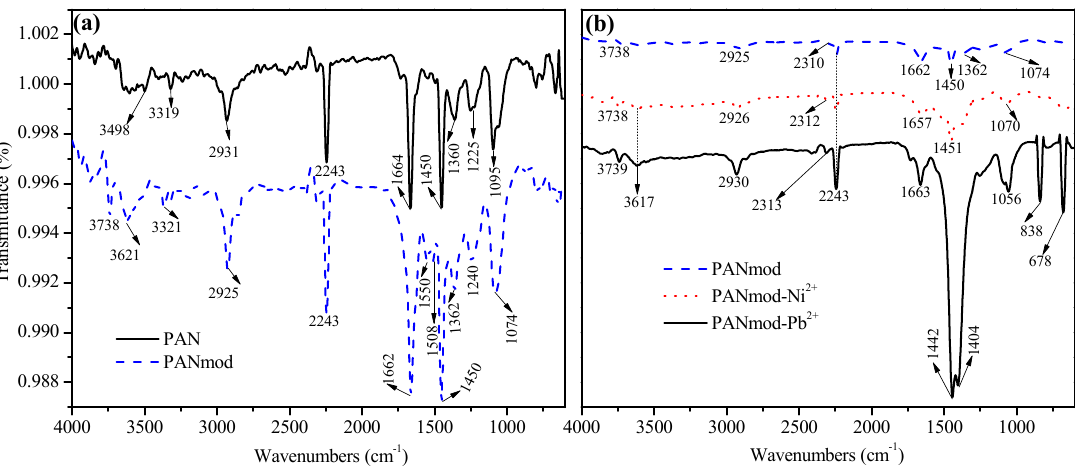
Figure 1. Fourier ‐ transform infrared spectrometry (FTIR) analysis of ( a ) the polyacrylonitrile (PAN) nanofibers and PAN nanofiber activated with NaHCO 3 (PANmod) and ( b ) PANmod, PANmod ‐ Ni 2+ and PANmod ‐ Pb 2+ .